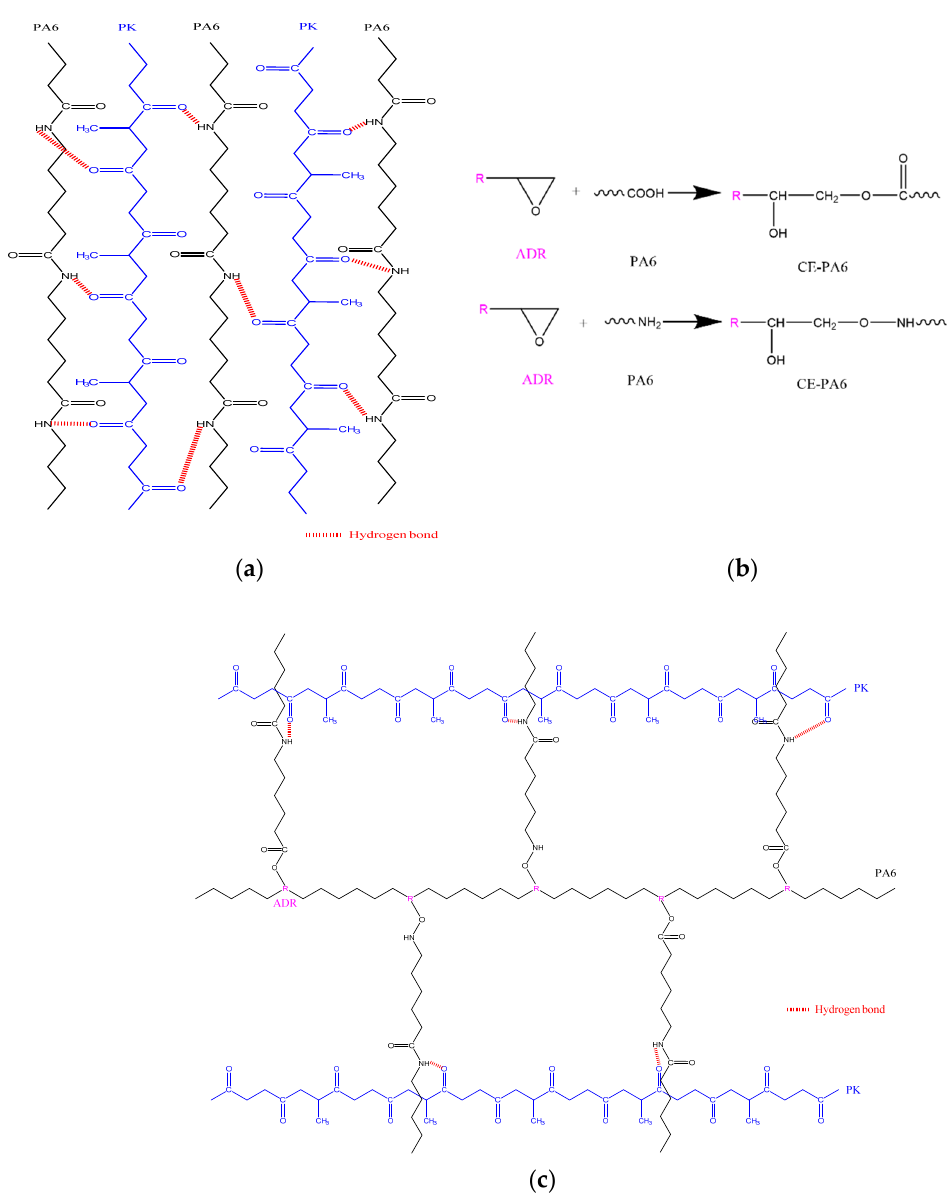
Figure 2. Schematics of chain extension: ( a ) PA6/PK blends; ( b ) PA6 with ADR; ( c ) PA6/PK blends with ADR.